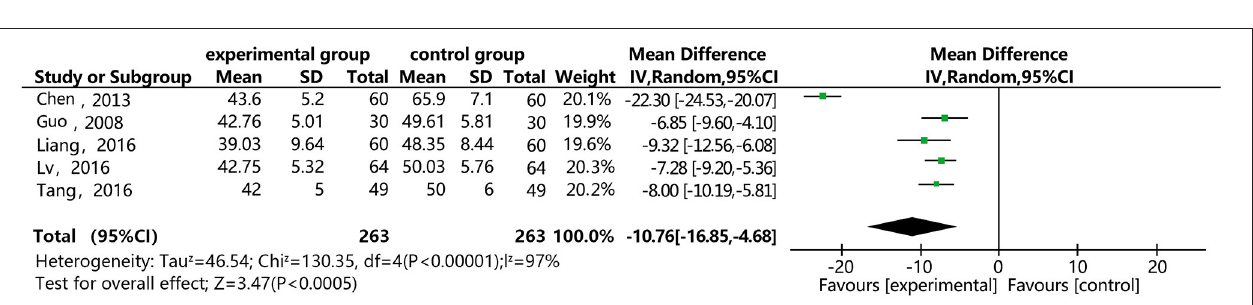
FIGURE 11 | Meta-analysis forest map for the effect of DSP combined with aspirin on plasma viscosity in patients.